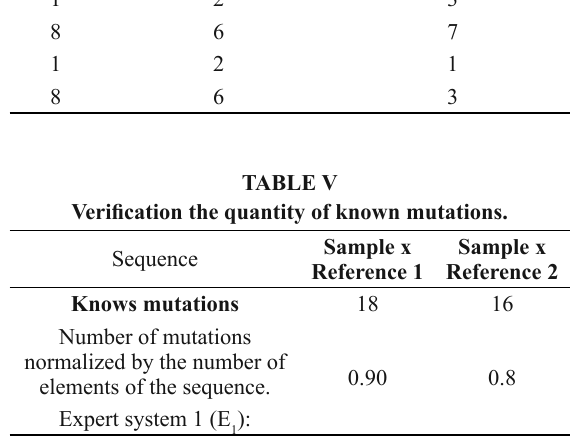
elements of the sequence.